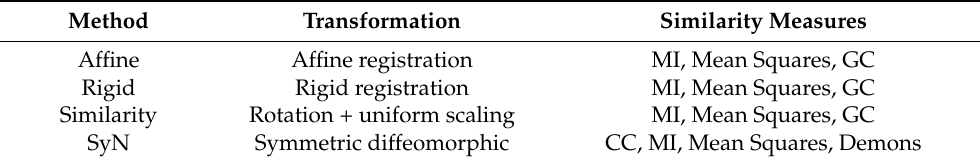
Table 1. Compared methods. Similarity measure acronyms: CC = neighborhood cross-correlation, Mean Squares = mean squared difference, MI = mutual information.